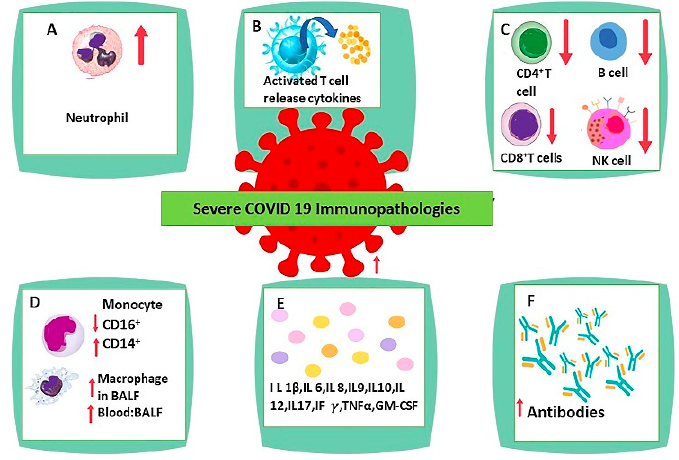
Figure 1. Immunopathological characteristics in severe SARS-CoV-2 infection include: ( A ) Neu- trophilia, ( B ) T cell activation with cytokine release, ( C ) Lymphopenia, ( D ) Monocyte and macrophage dysregulation, ( E ) Cytokine Storm, and ( F ) Increased production of antibodies. Note: Upward arrow mean increased and downward arrow mean decreased.